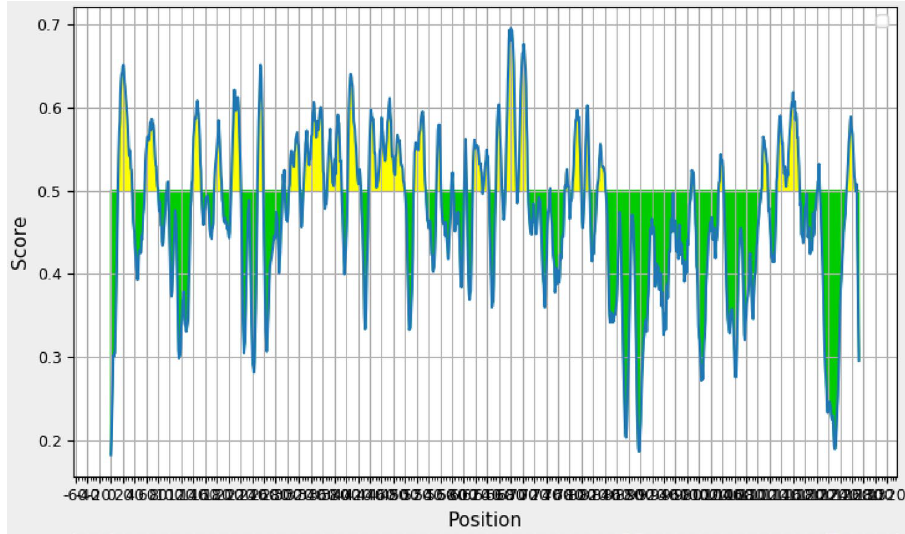
Figure 2. BepiPred linear epitopes predicted via IEBD analysis resource 20 .